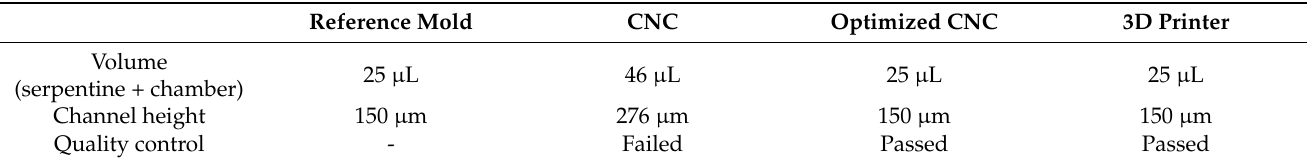
Table 1. Inspection and quality control test: microfluidics chips from the different fabricated